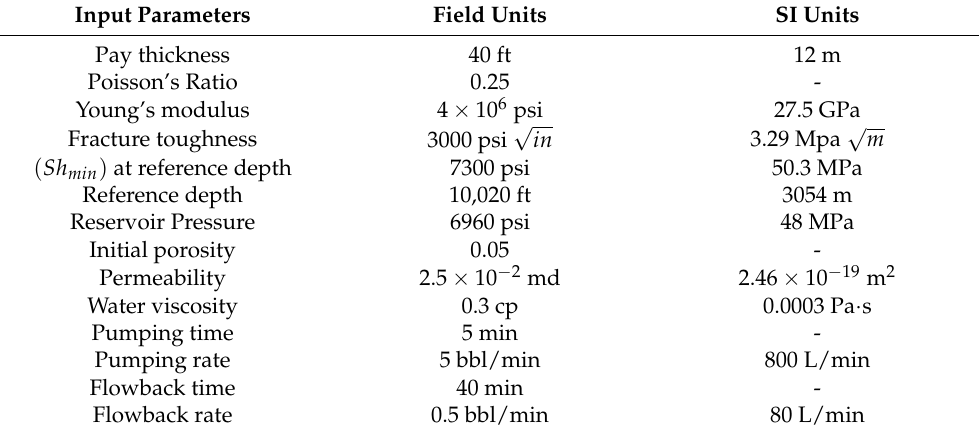
Table 2. Input parameters for base simulation